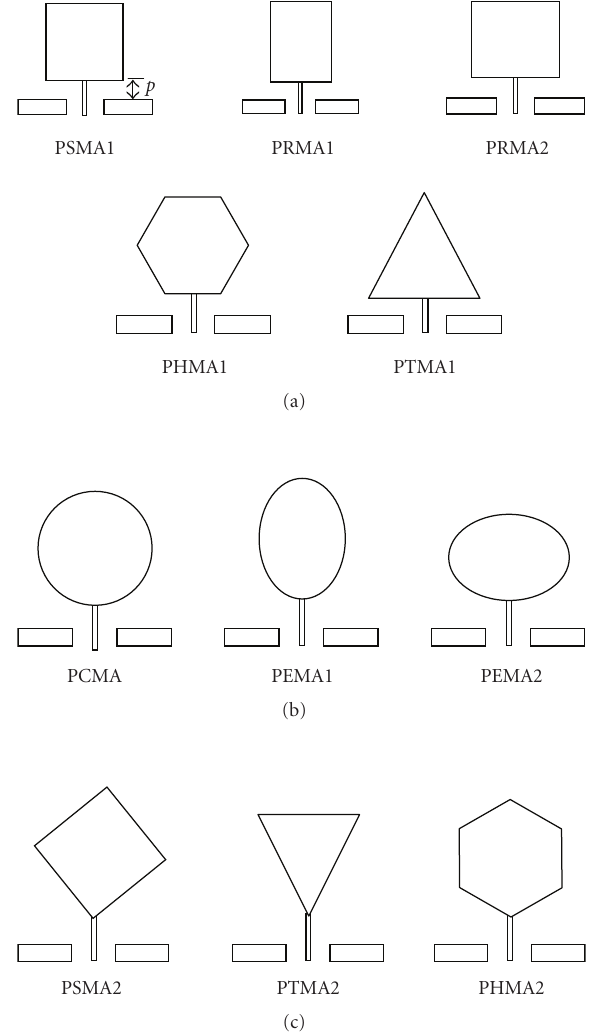
Figure 1: Various regular-shaped PMAs with di ff erent feed config-